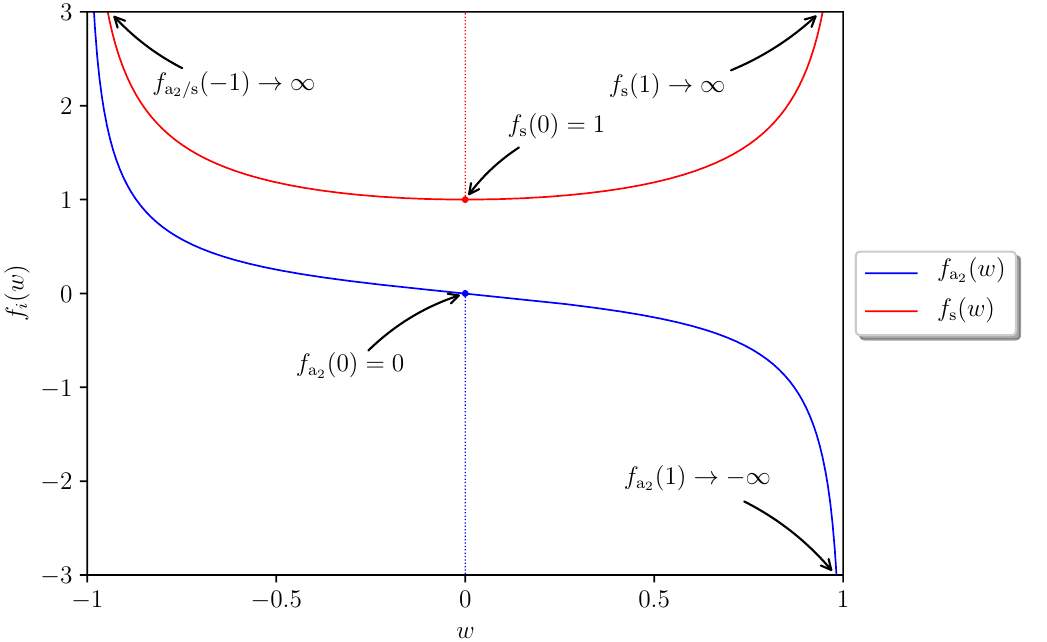
Figure 2 . Asymmetry functions f a cases w ∈ {− 1 , 0 , 1 } , corresponding to q 2